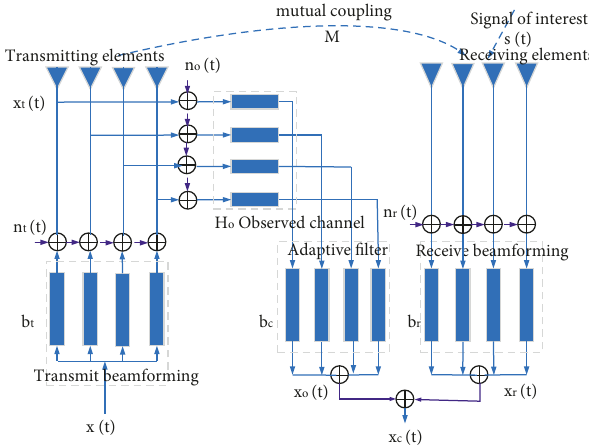
Figure 1: Block diagram of ALSTAR cancellation